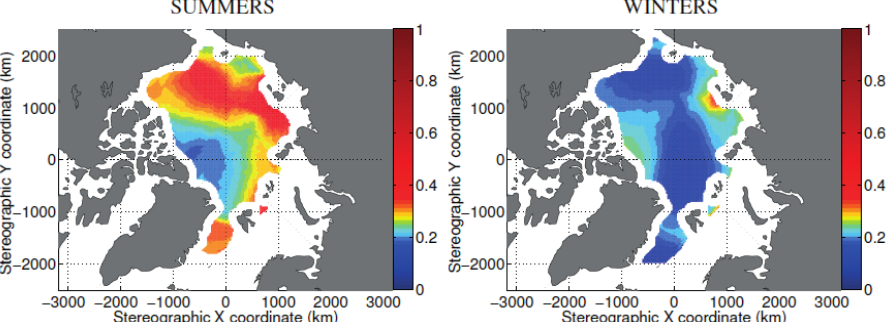
Figure 9. Spatial distribution of the magnitude of inertial oscillations in Arctic sea ice in summer in (a) 1979–2001 and (b) 2002–2008. The colour scale presents a non-dimensional parameter that Gimbert et al. (2012a) calculated to represent the magnitude of inertial oscillation. Reproduced with permission from Gimbert et al.